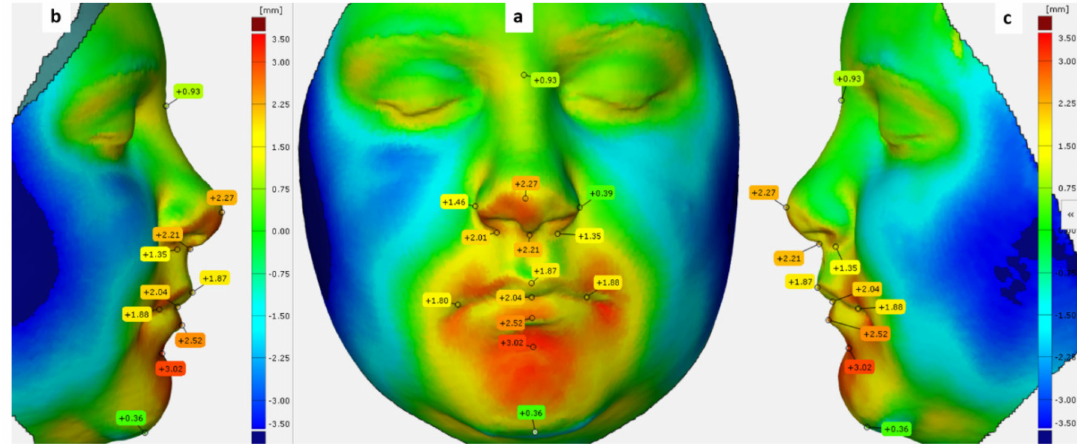
Figure 7. Deviation labels of the facial soft tissue landmarks used in our study. ( a ) Frontal view ( b ) and ( c ) lateral